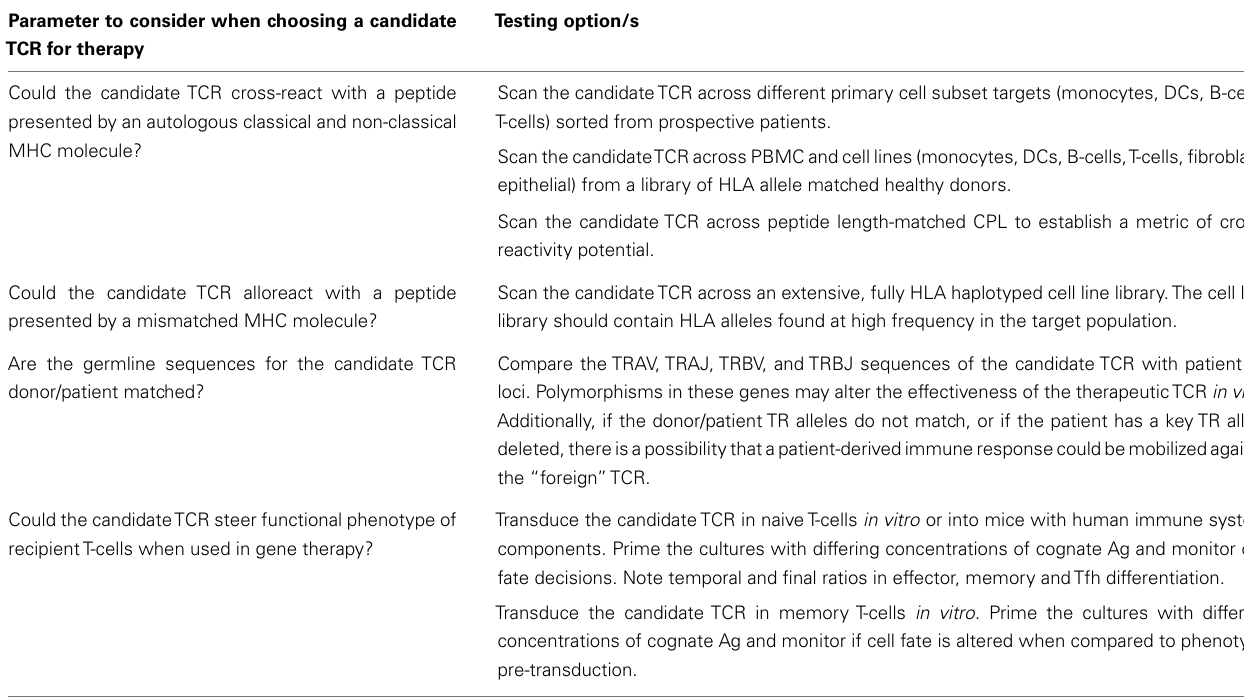
Table 1 | Pre-clinical testing options for therapeuticTCR